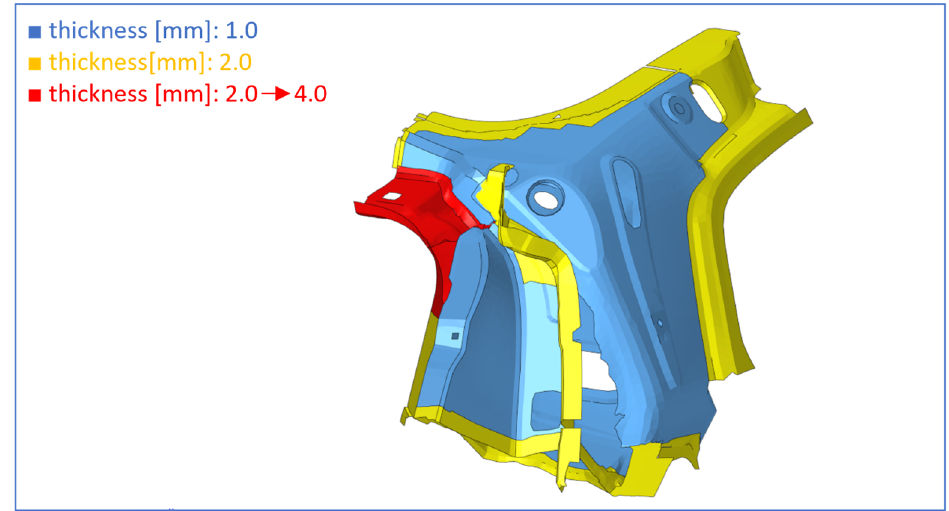
Figure 24. Hinge attachment, with increased thickness from 2 to 4 mm in the area highlighted in red.